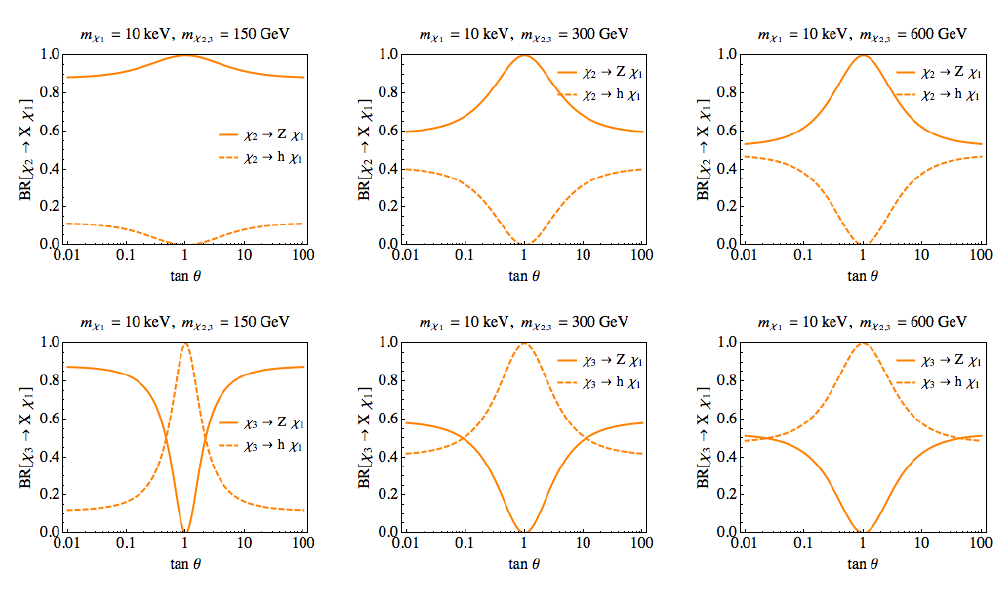
Figure 9 . Branching ratios of (cid:31)